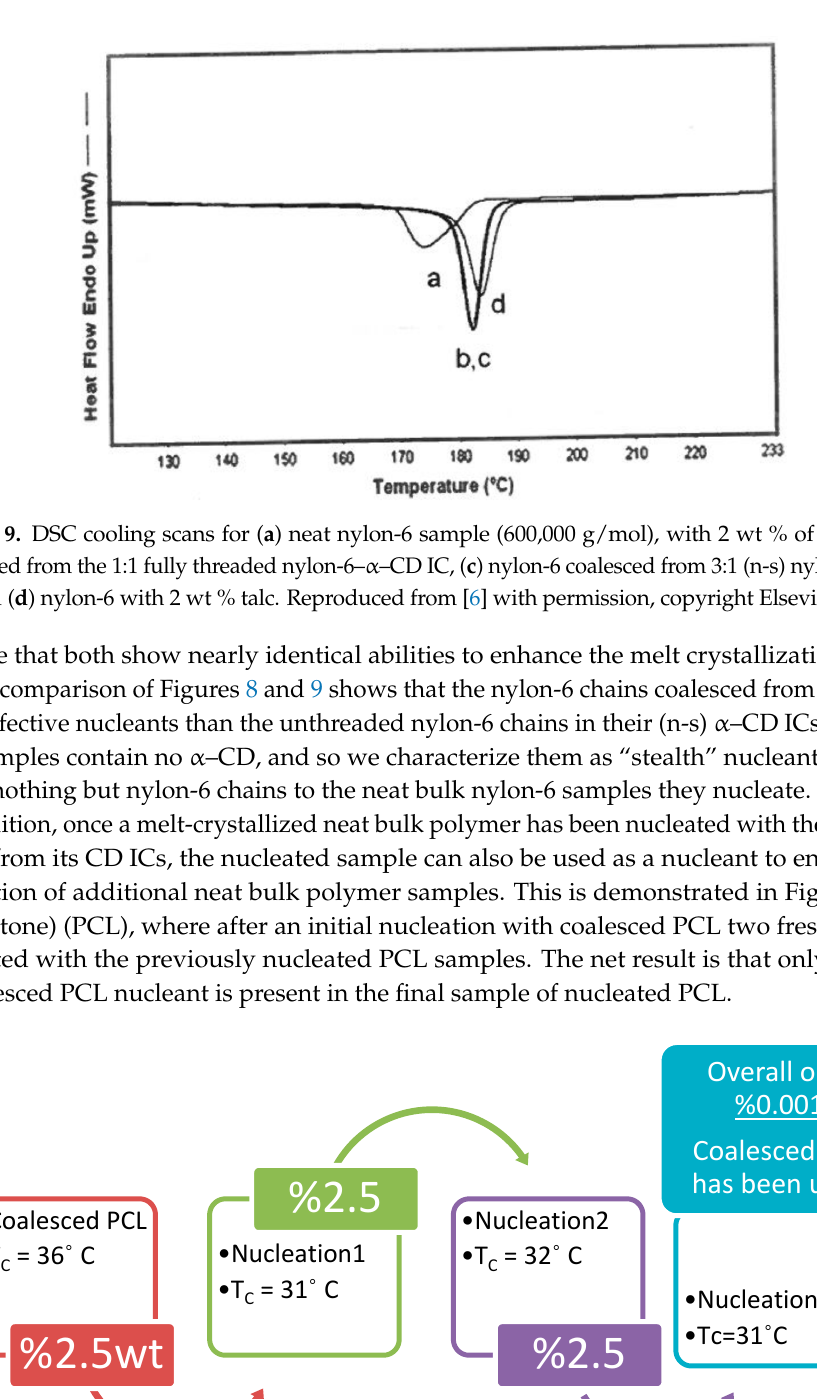
Figure 8. DSC cooling scans (5 °C/min) for neat ( a ) nylon-6 sample (600,000 g/mol) ( b ) nylon-6 with 2